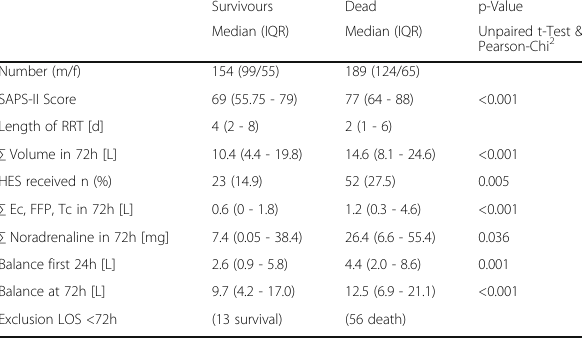
Table 105 (abstract A334). Impact on